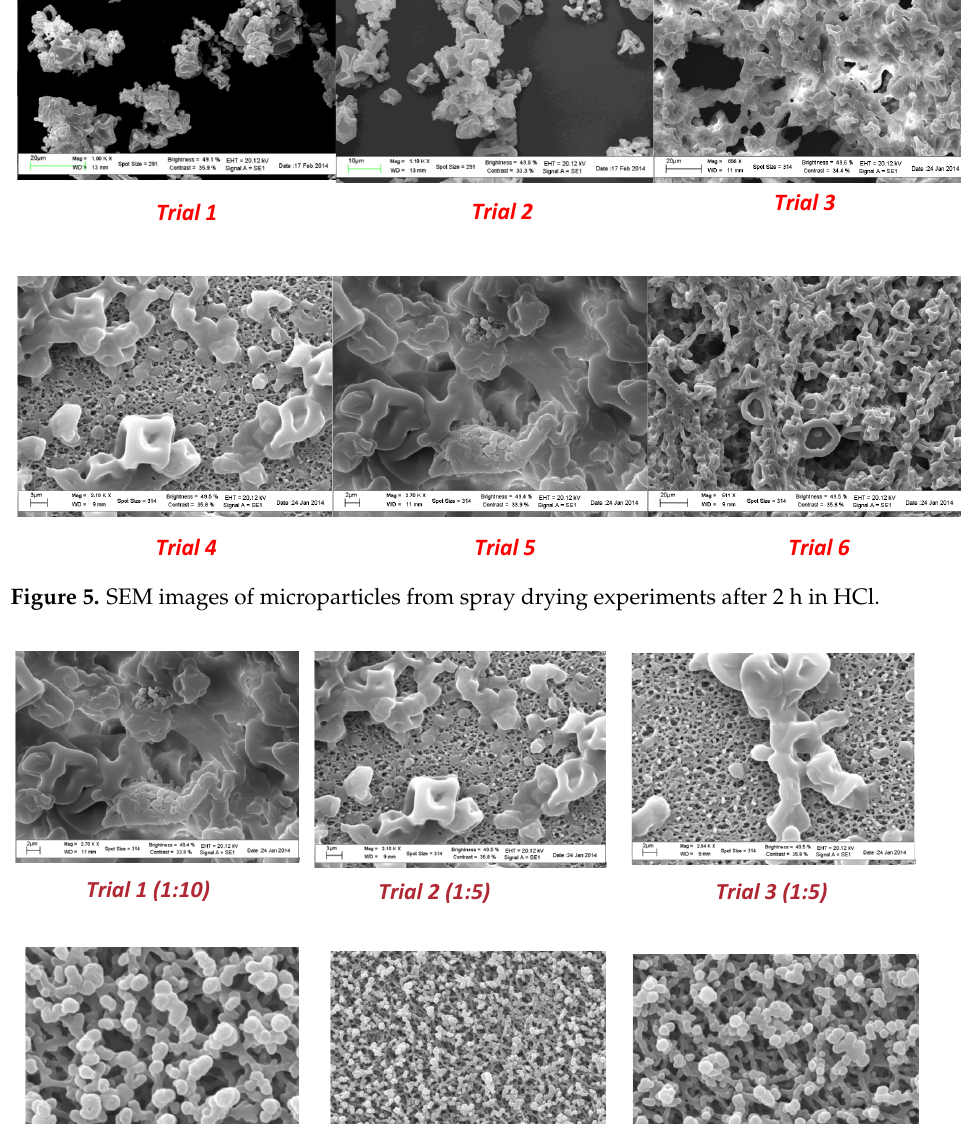
Figure 6. SEM images of microparticles from spray drying experiments after 24 h in PBS solution.